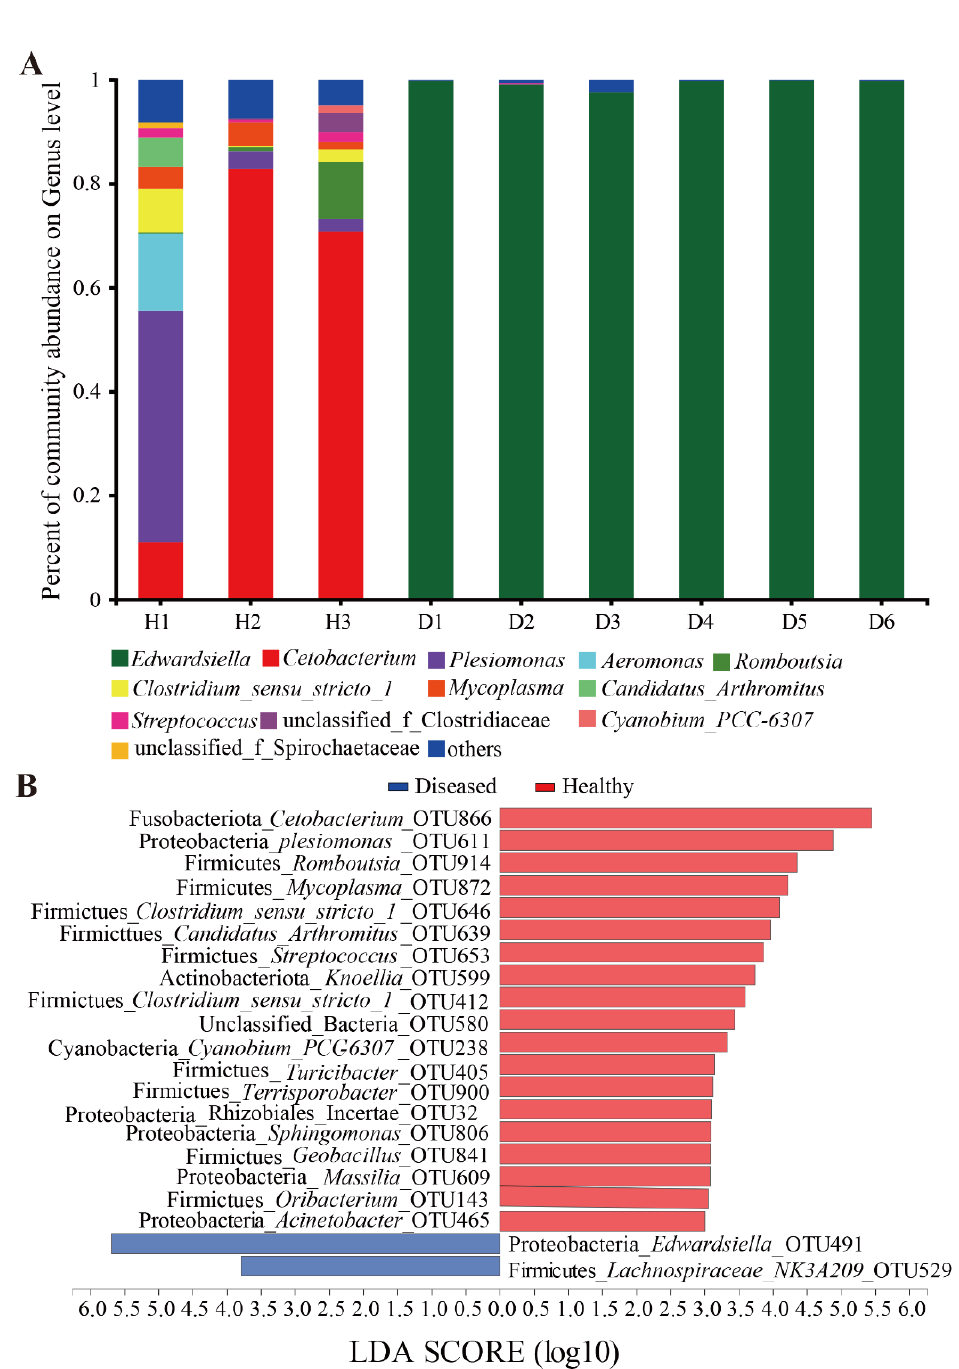
Figure 3. ( A ) Composition of the bacterial communities at the genus level in the intestinal microbiota of the sampled yellow catfish. ( B ) LEfSe identified the most differentially abundant OTUs in the intestinal microbiota of the healthy and the diseased yellow catfish. H1~H3: healthy fish; D1~-D6: diseased